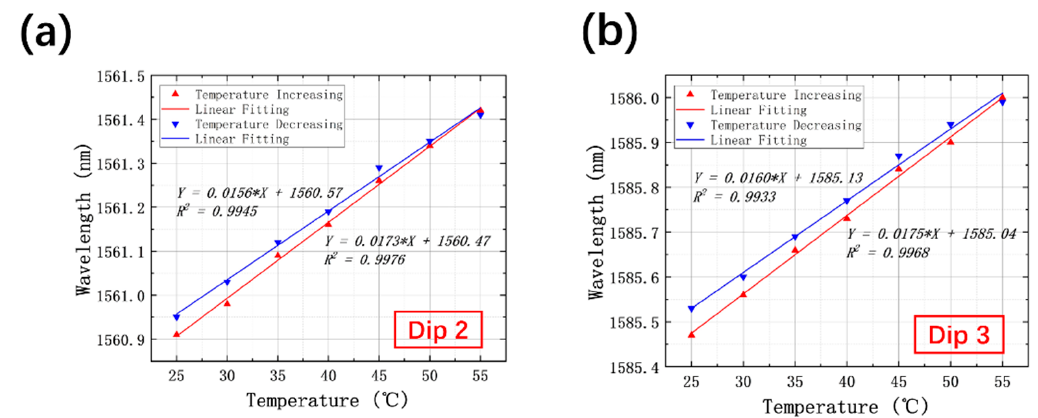
Figure 7. ( a ) Transmission spectra of the HCBF-based sensor under different temperature values; ( b ) enlarged transmis- sion spectra in the region of Dip 2, inset shows the relationship between the intensity of Dip 2 and temperature.